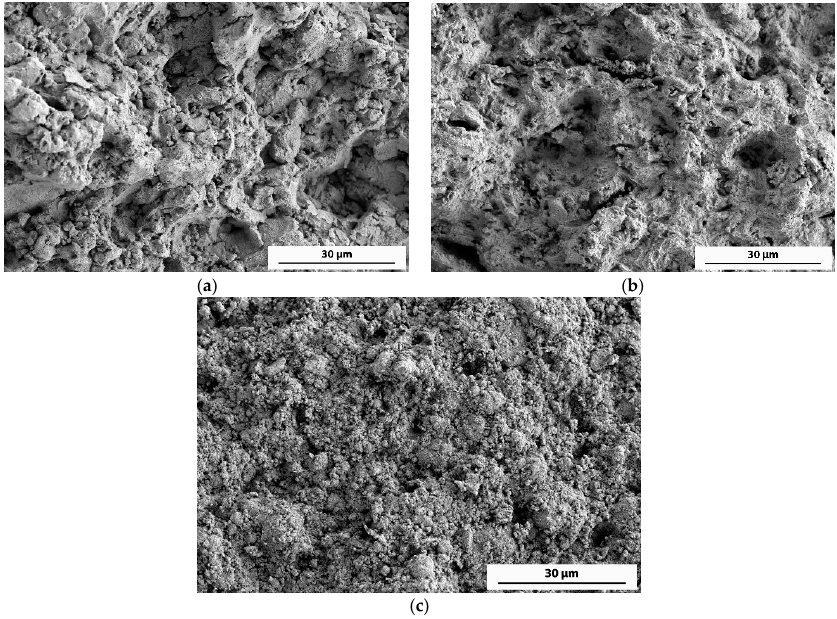
Figure 6. FEGSEM (field emission scanning electron microscopy) secondary electrons microfractographs of the fracture surface of ( a ) 10’A, ( b ) 4V + 1A, and ( c ) 1V + 4A compacts.